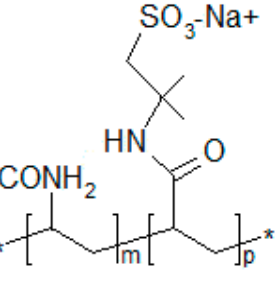
Figure 3. Structure of sulfonated polyacrylamide. Table 2. Polymer